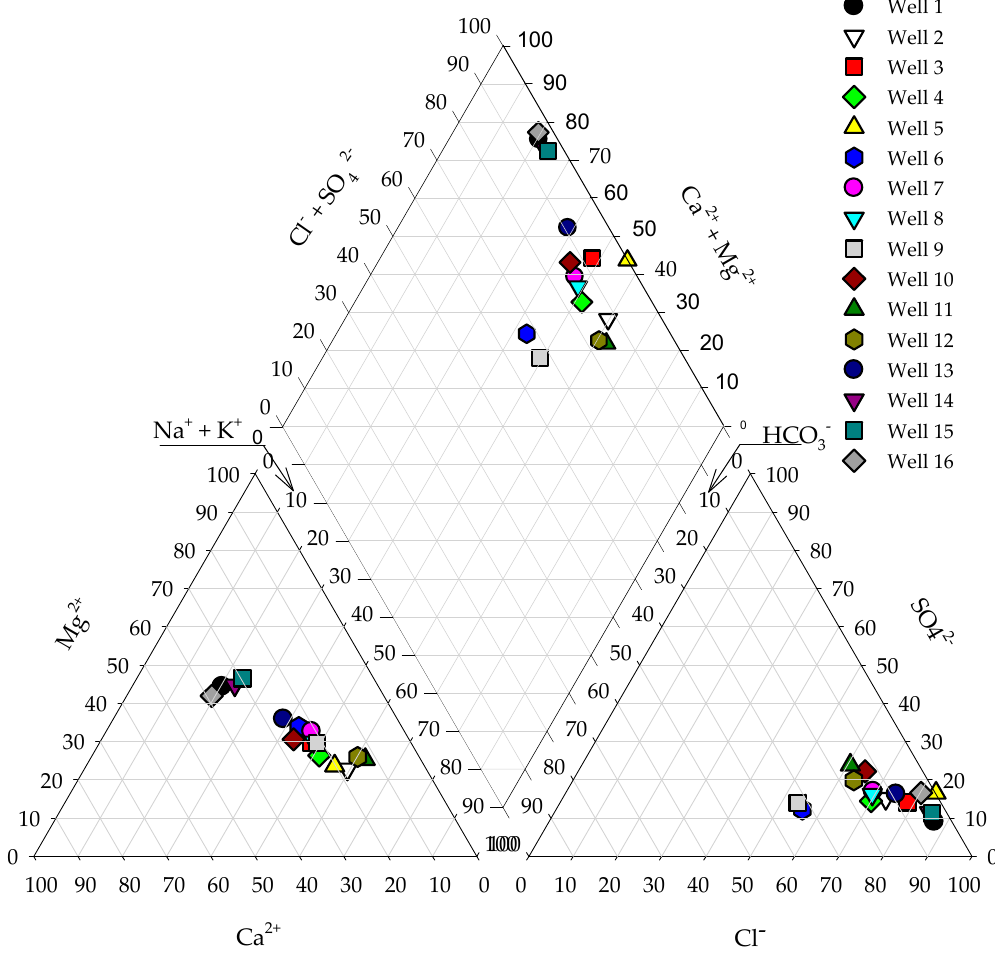
Figure 4. Piper diagram for the 16 wells under monitoring.